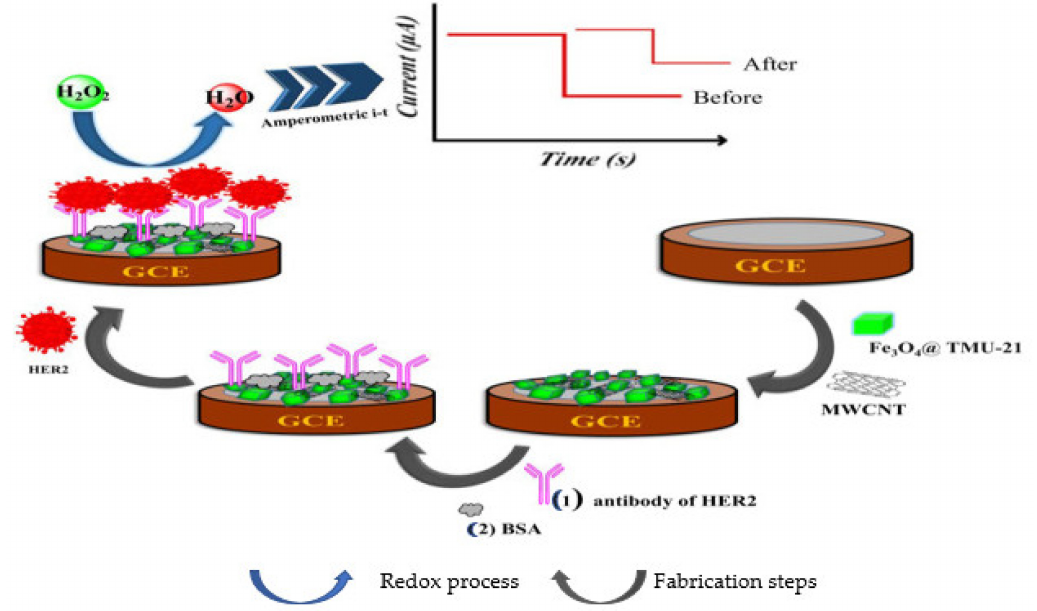
Figure 12. Schematic illustration of the construction process of an immunosensor. Reprinted with permission from [95], published by Elsevier,